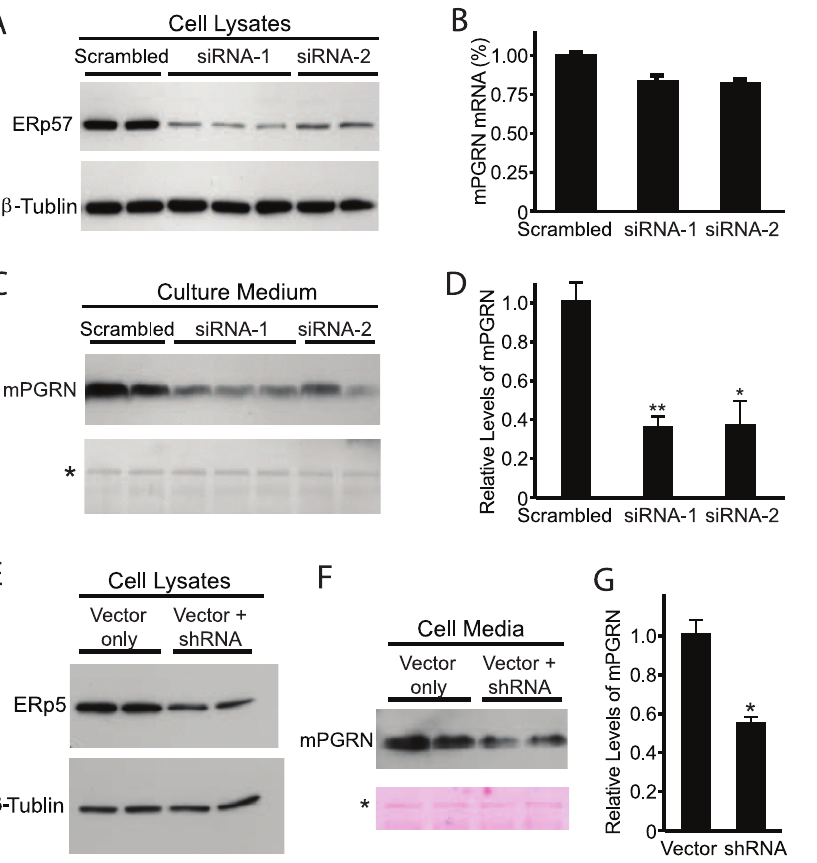
Figure 6. Loss of ERp57 activity caused reduced PGRN secretion. ( A ) Western blot analysis of the efficiencies of siRNA knockdown of ERp57 expression in stably transfected HEK293 cells expressing mPGRN. b -tubulin was used as the loading control. ( B ) qRT-PCR analysis of relative mPGRN mRNA levels after siRNA treatment. ( C ) mPGRN levels in the culture medium were measured by Western blot with anti-mPGRN antibody. Asterisk indicates a protein band of unknown identity visualized by staining of the Western blot membrane with Ponceau S to indicate equal loading. ( D ) Quantification of mPGRN levels in C . The values are mean 6 SEM. * p , 0.02, ** p , 0.002 vs. scrambled control. This experiment was repeated three times with similar results. ( E ) A vector-based shRNA construct reduced ERp5 expression level in stably transfected HEK293 cells expressing mPGRN. b -tubulin was used as the loading control. ( F ) Levels of secreted mPGRN were reduced in the culture medium of HEK293 cells with partial knockdown of ERp5. Asterisk indicates a protein band of unknown identity visualized by staining of the western blot membrane to indicate equal loading. ( G ) Quantification of the levels of mPGRN in F . Values are mean 6 SEM. * p , 0.02. This experiment was repeated three times with similar results.